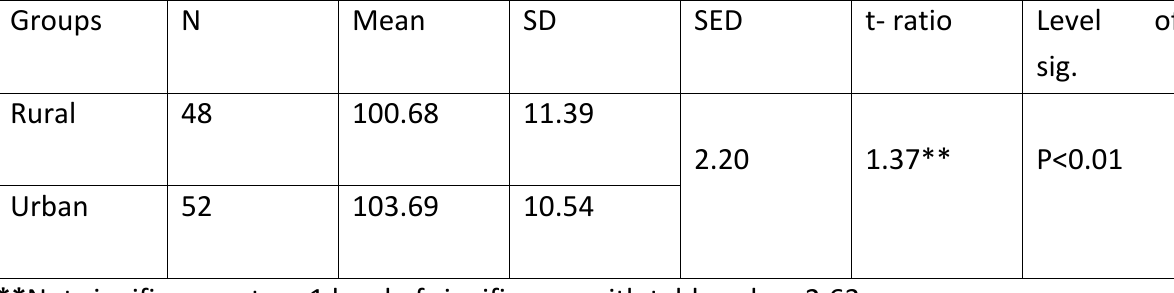
Table 5: Significance Difference in the Mean Score of rural and urban Secondary